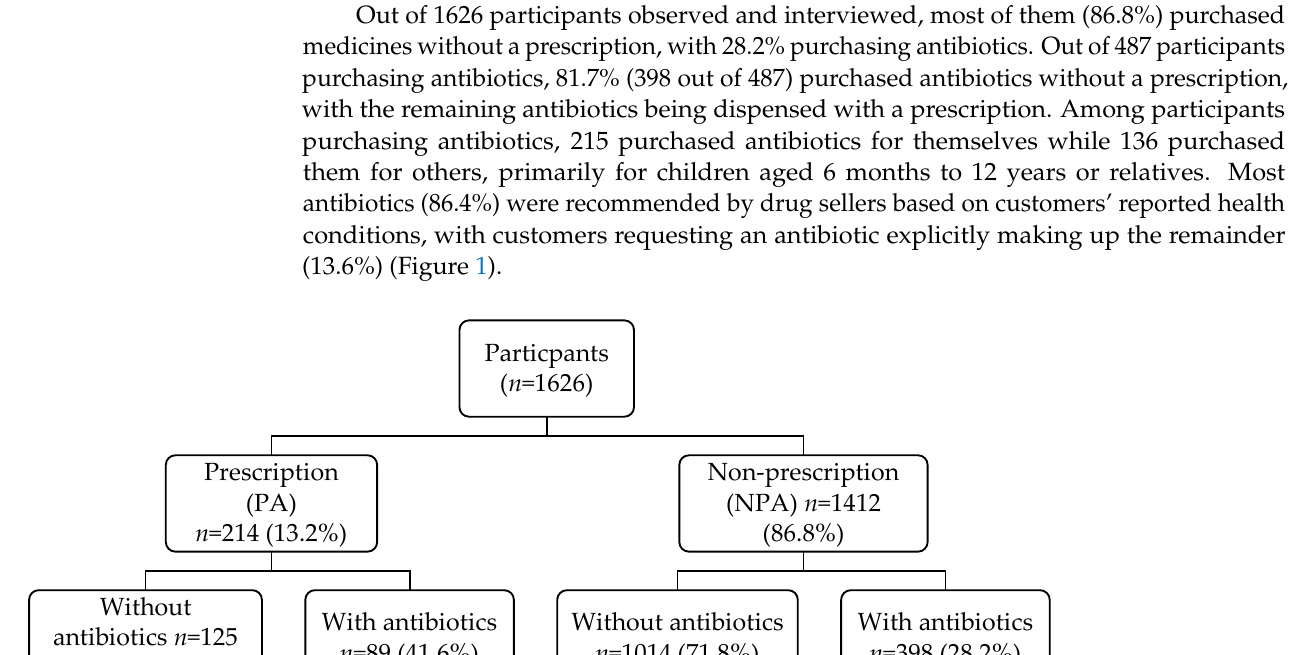
Figure 1. Flow chart of participants